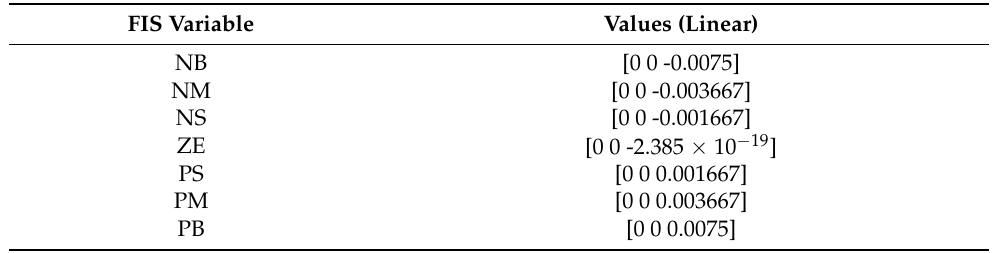
Table 2. Output FIS variables.